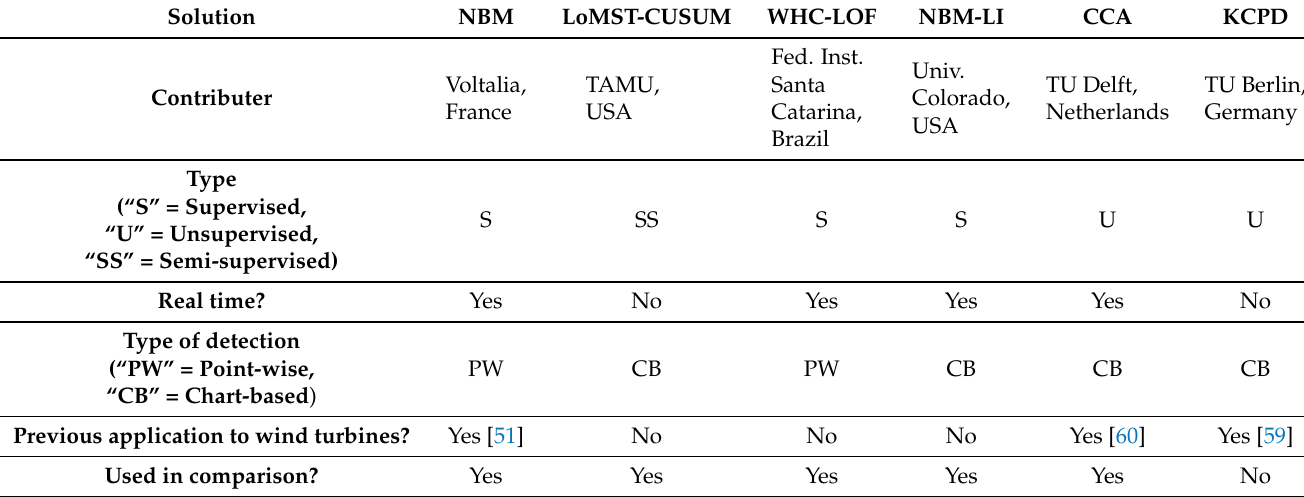
Table 3. Summary of the solutions examined in this work.